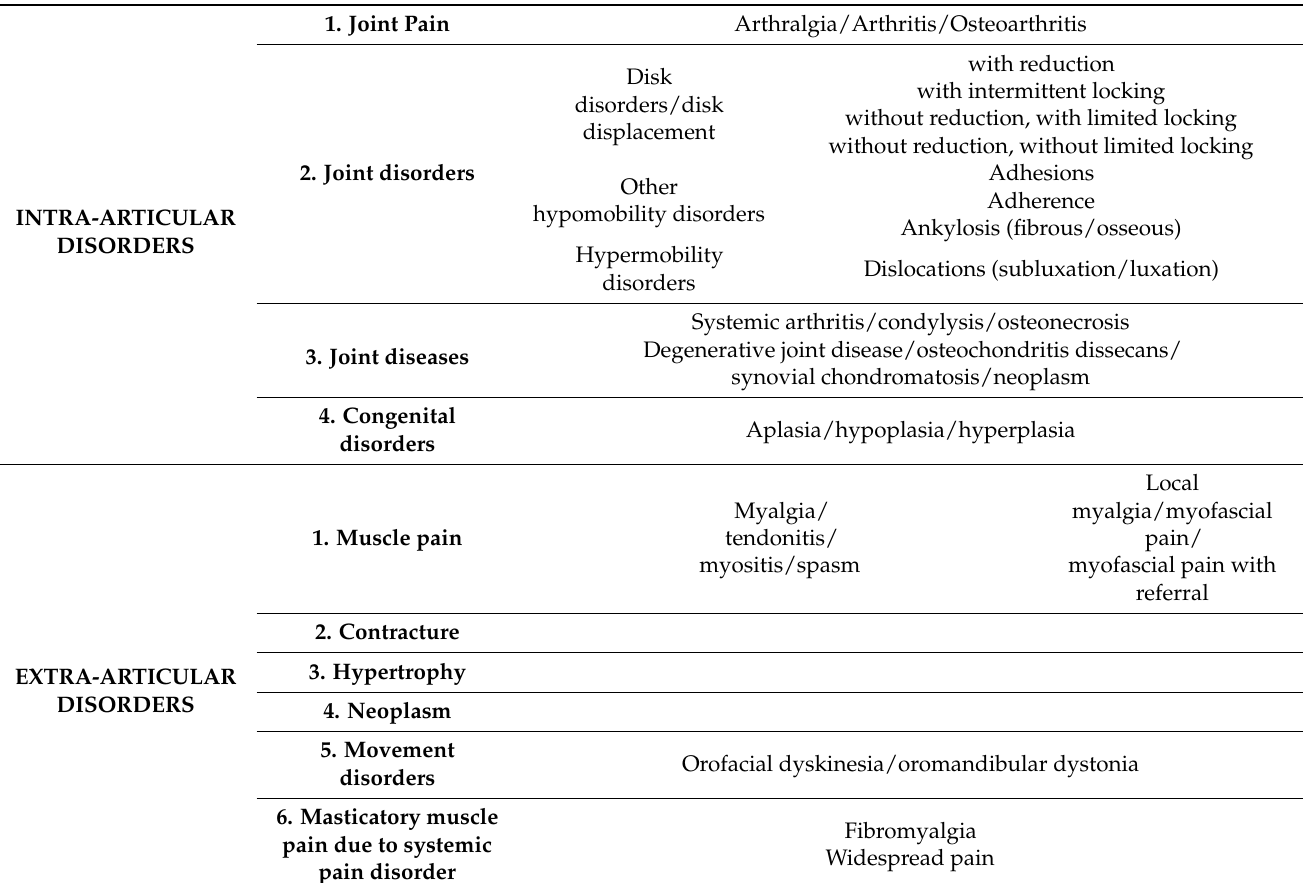
Table 1. Classification of intra-articular and extra-articular temporomandibular